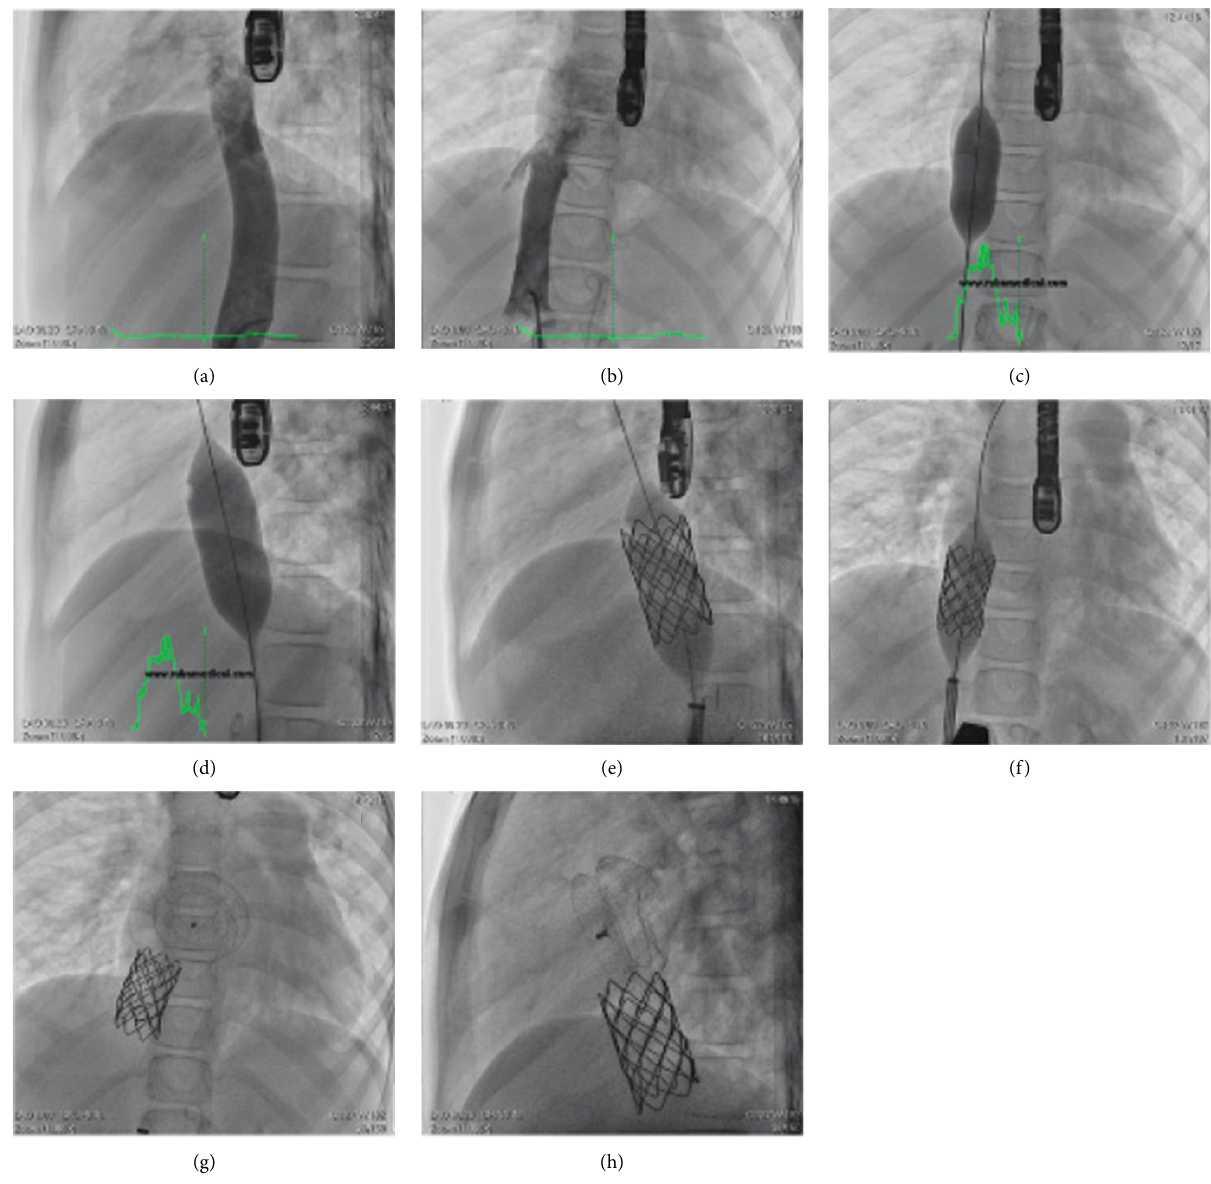
Figure 5: (a, b) IVC angiogram in frontal and lateral views demonstrates the diameter of the IVC at its entrance into the right atrium in order to select the proper size of the balloon. (c, d) Cine angiogram of the heart in frontal and lateral projections demonstrates the inflated Z- med balloon 25 × 40 mm at the entrance of the IVC to document that the inflated balloon can created an inferior rim. (e, f) Cine angiogram of the heart in frontal and lateral projection demonstrates the inflated uncovered CP stents at the entrance of the IVC into the right atrium. (g, h) Cine angiogram of the heart in frontal and lateral projection demonstrates proper implantation of uncovered CP stent at the entrance of the IVC, creating an inferior rim which makes the closure of the ASD secundum with an absent inferior rim possible and effective by the atrial septal